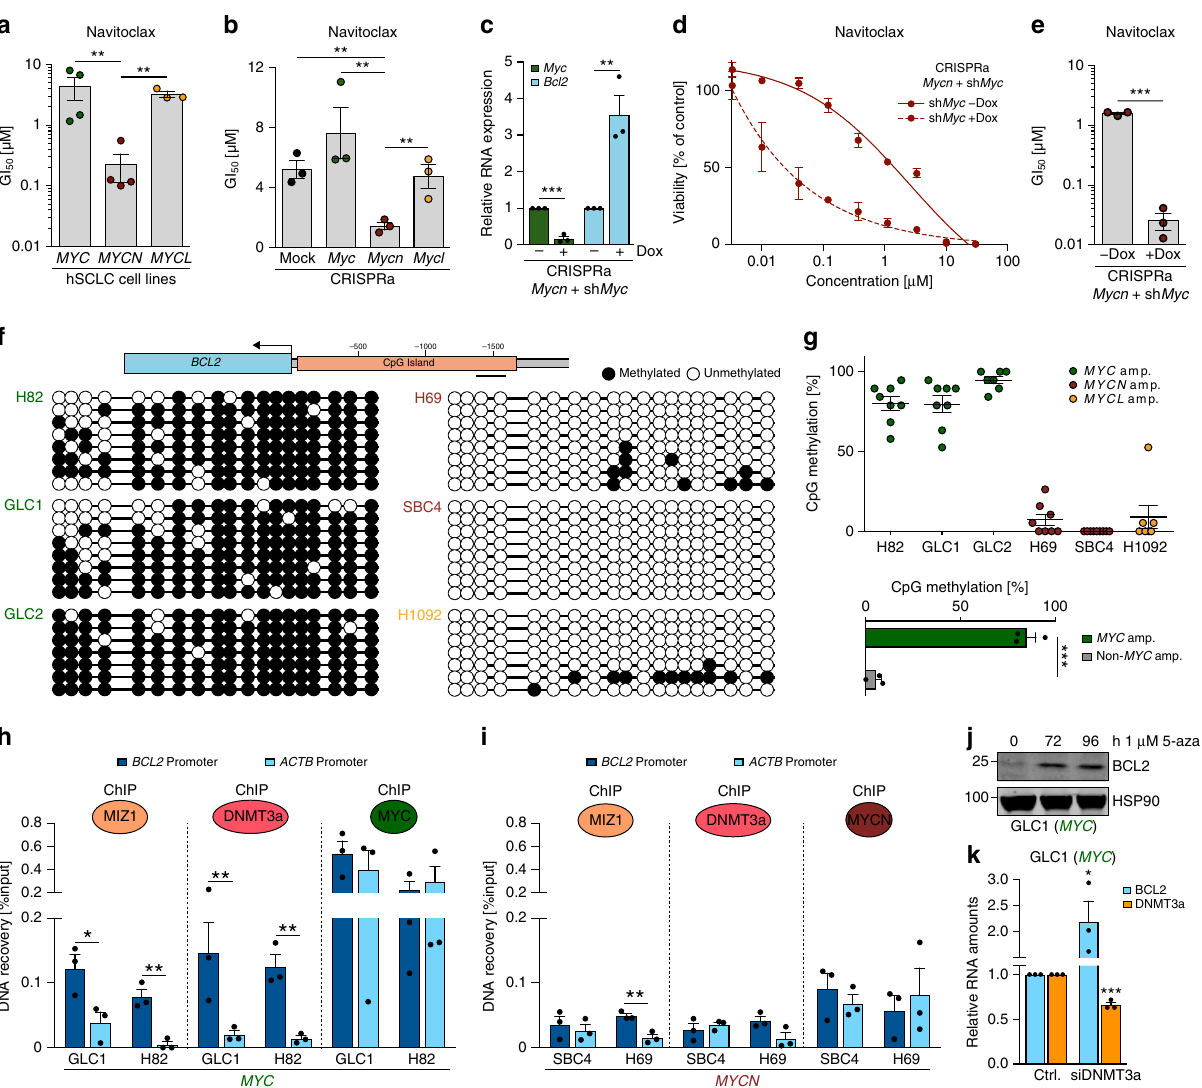
Fig. 2 MYC represses BCL2 expression. a GI 50 values of MYC ( n = 4; GLC1, H82, H524, GLC2), MYCN ( n = 4; GLC8, H69, SBC4, COR-L303), and MYCL ( n = 3; H1092, H2029, SBC7) human small cell lung cancer (SCLC) cell lines treated with navitoclax for 72 h ( n = 3). b GI 50 values of Myc paralog- activated CRISPRa cells treated with navitoclax for 96 h ( n = 3). c Relative mRNA levels (quantitative reverse transcription polymerase chain reaction (qRT- PCR)) of Myc and Bcl2 in Mycn -activated CRISPRa cells with Tet-inducible Myc knockdown by shRNA at 72 h after doxycycline treatment ( n = 3). Data were normalized to 18S rRNA. d Viability screening of Mycn -activated CRISPRa cells after Myc knockdown treated with navitoclax for 96 h ( n = 3). e GI 50 values of viability screening in d ( n = 3). f DNA methylation at the BCL2 promoter (indicated region) measured by bisul fi te sequencing. Lollipop diagram representing methylated (black) and unmethylated (white) CpGs in MYC (H82: n = 8, GLC1: n = 8, GLC2: n = 7), MYCN (H69: n = 8, SBC4: n = 8), and MYCL (H1092: n = 7) ampli fi ed human SCLC cell lines. g Percentage of methylated CpG residues in MYC (H82, GLC1, GLC2), MYCN (H69, SBC4), and MYCL (H1092) ampli fi ed human SCLC cell lines (top). CpG methylation percentage ( f ) in SCLC cell lines ( n = 6) grouped by MYC ampli fi cation status ( MYC -high n = 3, MYC -low n = 3; bottom). h , i Occupancy at the BCL2 promoter of MYC, MIZ1, and DNMT3a in MYC -ampli fi ed cells (GLC1, H82) ( h ) and of MYCN, MIZ1, and DNMT3a in MYCN -ampli fi ed cells (SBC4, H69) ( i ) measured by chromatin immunoprecipitation (ChIP) quantitative real-time PCR ( n = 3). ChIP signal is displayed as percentage of input. IgG (non-speci fi c antibody control) signal was subtracted from ChIP signal of speci fi c antibodies. j Western blot showing BCL2 in MYC- ampli fi ed GLC1 cells treated with 1 µ M 5-azacytidine for the indicated times. HSP90 was used as loading control. k Relative mRNA expression (qRT-PCR) of BCL2 and DNMT3a in MYC -ampli fi ed GLC1 cells treated with control small interfering RNA (siRNA) or DNMT3a siRNA ( n = 3). Data were normalized to 18S rRNA. Error bars indicate mean ± SEM. Two-tailed unpaired t tests, *** p < 0.001, ** p < 0.01, * p < 0.05. Source data are provided as a Source Data fi